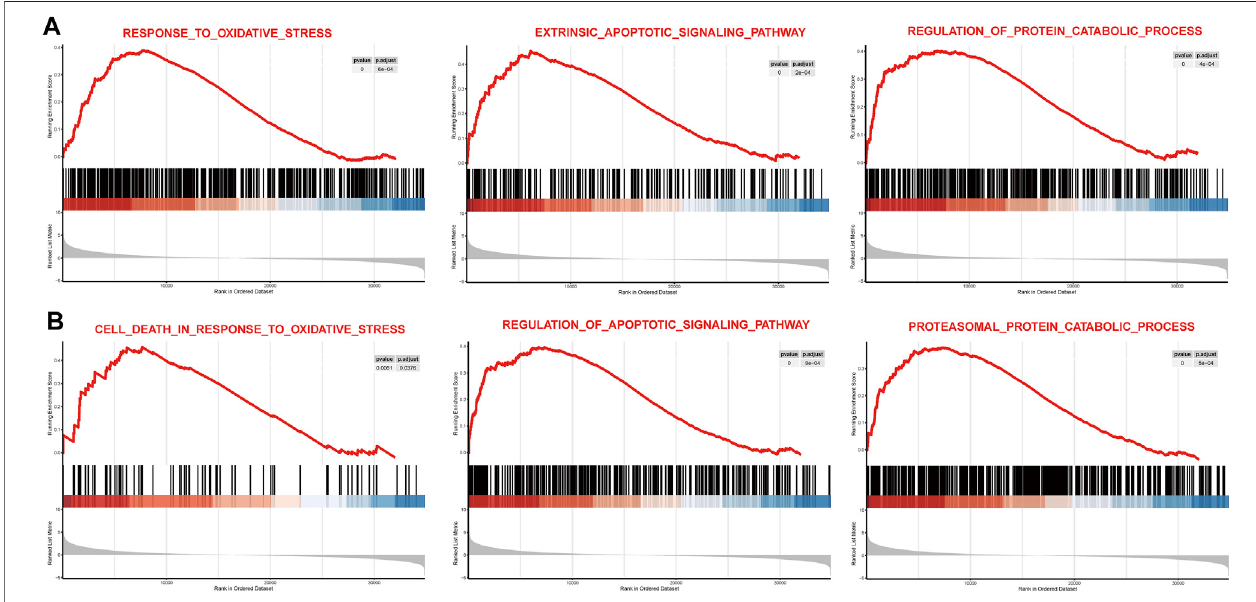
FIGURE3| MainfunctiongenesetenrichmentplotsbyGSEAinGSE77938andGSE151631. (A) GSEAenrichmentplotsforrepresentativepathwaysupregulated in KC compared to control in GSE77938. (B) GSEA enrichment plots for representative pathways upregulated in KC compared to control in GSE151631.